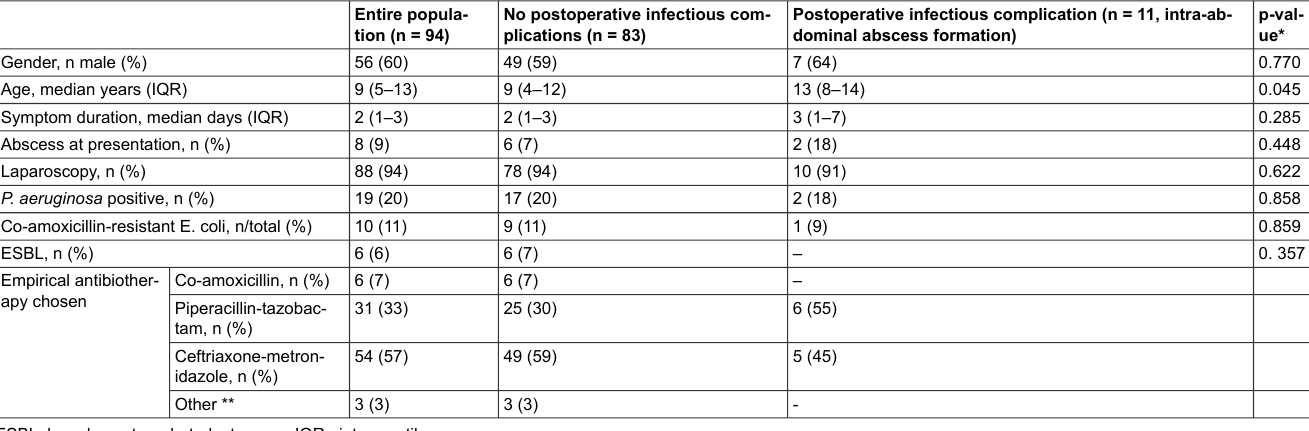
Table 1: Patient characteristics and potential determinants for post-operative infectious complications.